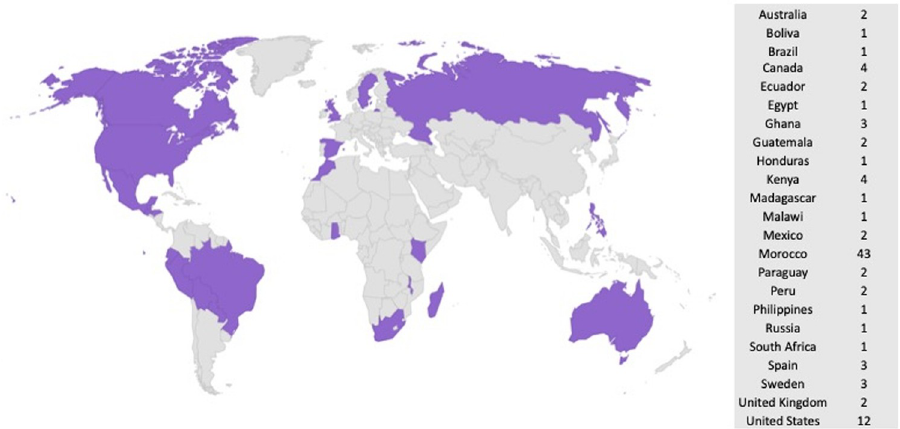
Fig 1. Home countries of volunteers who participated in the Oujda, Morocco mission. This map was generated and published with approval from amCharts (Vilnius, Lithuania).